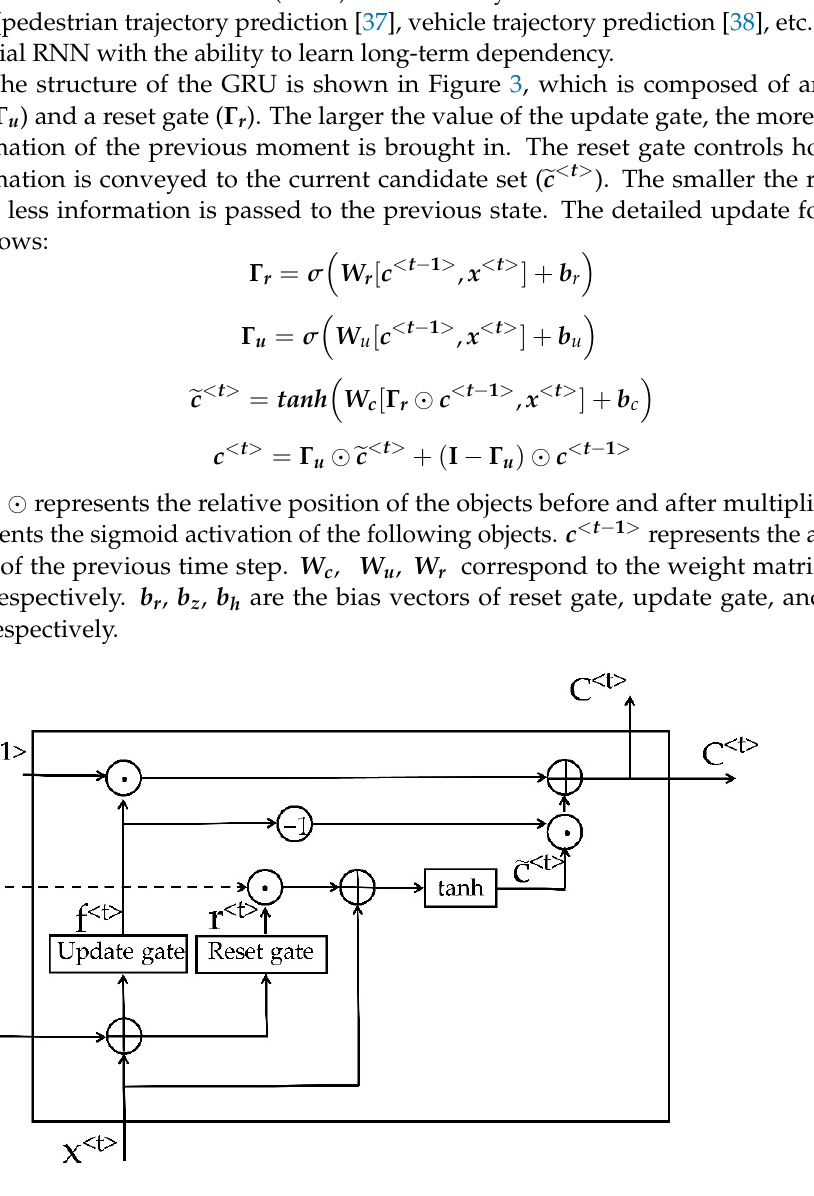
Figure 3. GRU block